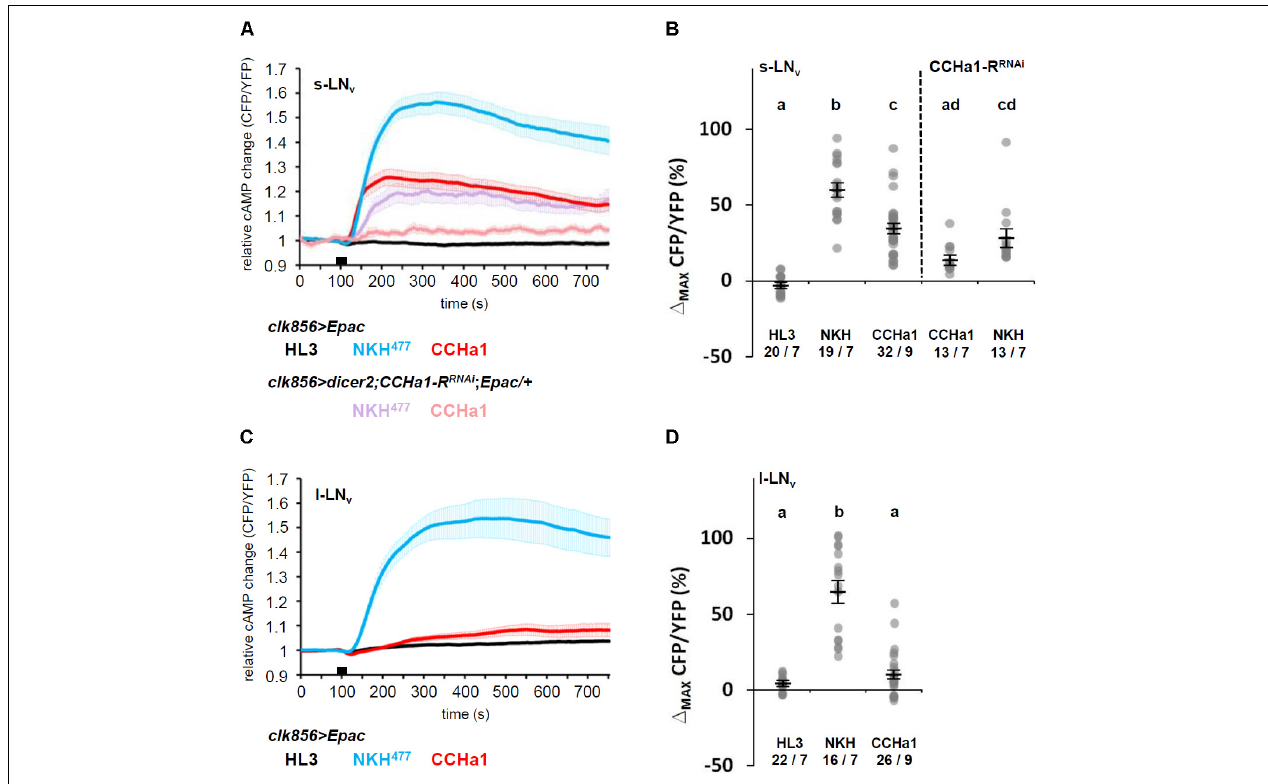
FIGURE 4 | Ex vivo live cAMP-imaging upon CCHa1 application to PDF-neurons. (A,C) Mean iFRET traces of s-LN v (A) and l-LN v (C) neurons over 750 s reflect intracellular changes in cAMP; application time is indicated by the black bar. The experiments were conducted between ZT6–9. Application of hemolymph-like saline (HL3, black) and NKH 477 (blue or purple) served as negative and positive controls, respectively. The cAMP level was increased only in s-LN v but not l-LN v neurons in response to bath-application of the CCHa1 peptide (red). This response was reduced in the s-LN v neurons when CCHa1-R was knocked down by RNAi (rosy). Error bars represent SEM. (B,D) Quantification of maximal inverse FRET changes for each treatment in the s-LN v (B) and l-LN v (D) neurons; changes after NKH 477 -application were significantly different from the negative control in both neuronal subgroups ( p < 0.001), whereas changes after CCHa1-application were different from the negative control only in the s-LN v neurons ( p < 0.001). When CCHa1-R was knocked down, s-LN v responses to CCHa1 were not significantly different from the negative HL3 control ( p > 0.05), whereas application of NKH 477 still evoked significant increases in cAMP levels ( p < 0.001). There was, however, no difference between CCHa1 and NKH 477 applications in the CCHa1-R knockdown. Gray dots represent values of single neurons, black horizontal lines indicate mean ± SEM. Statistical significances are indicated by the letter code (values that were not statistical different from each other are marked by the same letter). Numbers at the bottom indicate numbers of neurons/numbers of